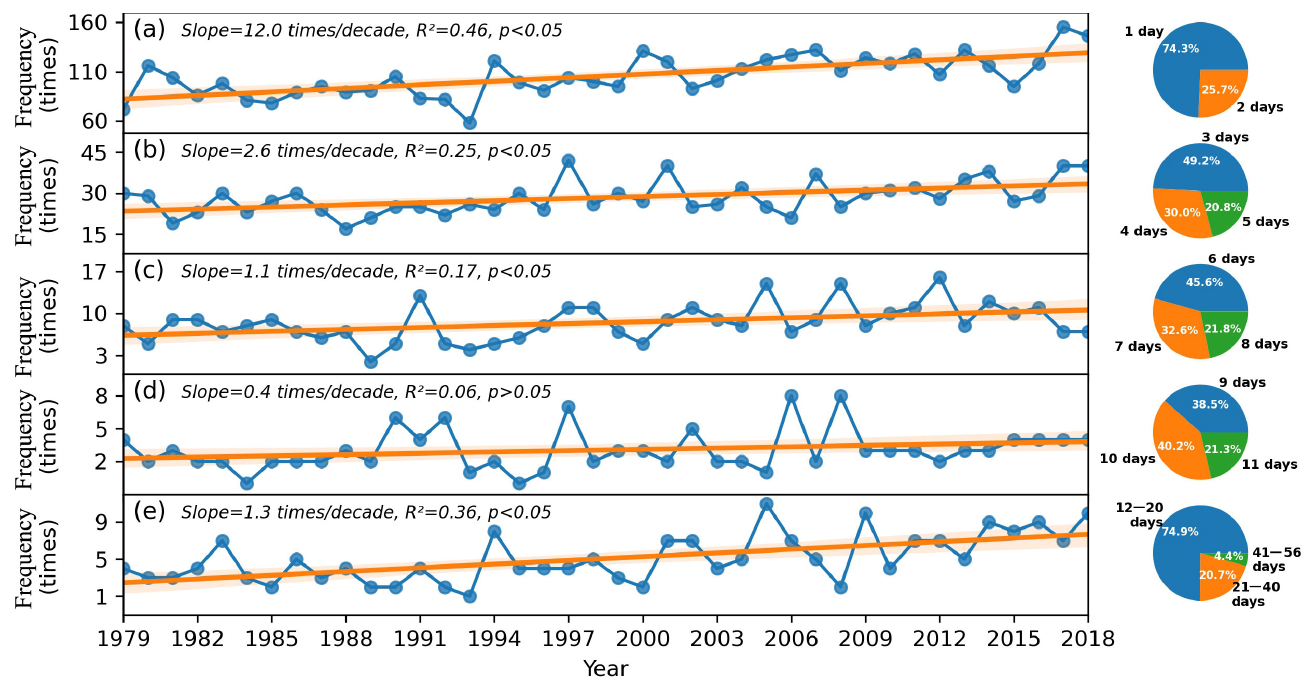
Figure 3. Variations in frequency of heatwave events in the 1979–2018 period across China. Green bars represent the number of heatwave events less than the average of 150 times, while the red bars denote above 150 times; distinguished colors for lines illustrate change trends in different periods as: 1979–2018 (black), 1979–1988 (blue), 1989–1998 (orange), 1999–2008 (brown), and 2009–2018 (pur- ple).